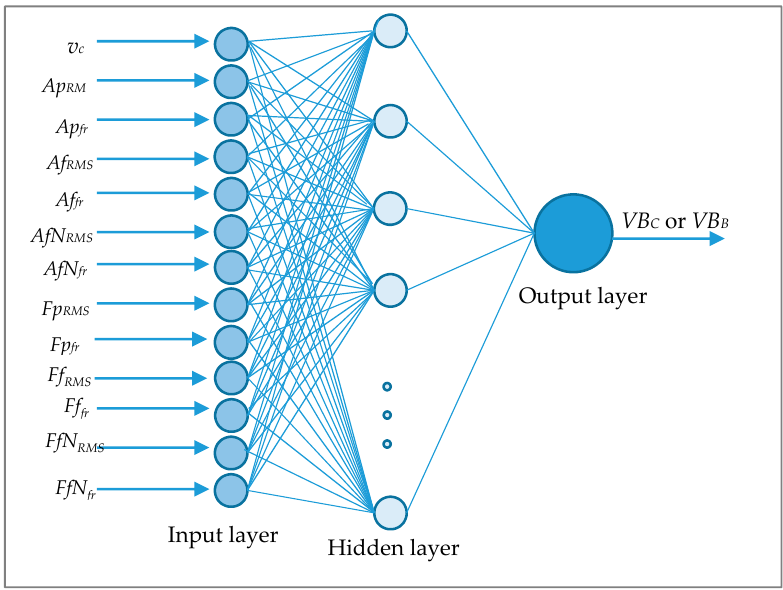
Figure 7. Structure of multilayer perceptron (MLP) network for tool wear prediction.